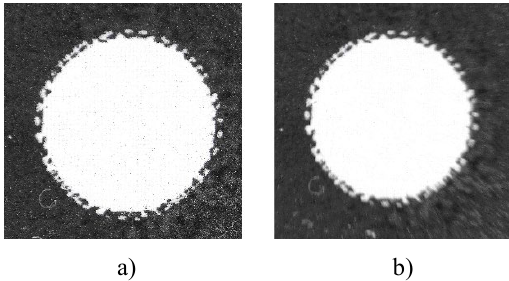
Fig. 4. An original halftone image of the round mark: a) in the absence of vibration; b) in the presence of vibration. Then the vibration was excited. The vibration was regulated by the indications of a contact sensor: harmonic vibrations of frequency 50 Hz, and vibration acceleration amplitude 1 g , 2 g , ..., 9 g was successively formed, where g is the acceleration of gravity. the maximum experimental vibration of 9 g . For each value of the vibration acceleration amplitude measured in g units, the corresponding value of the